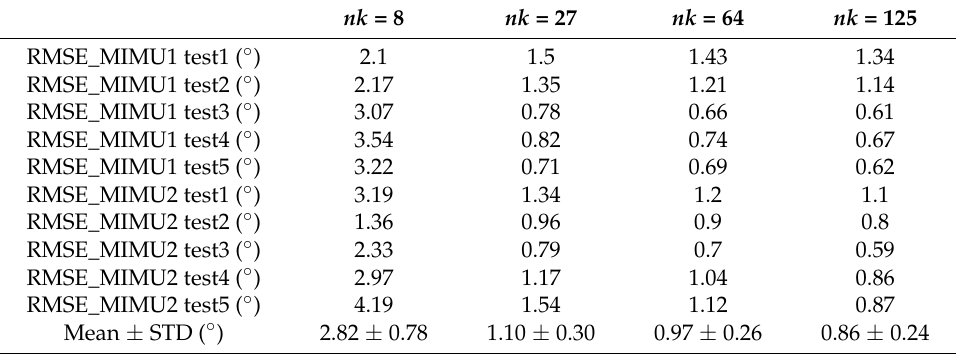
the interpolation. Mean errors ± standard deviation are reported in the final